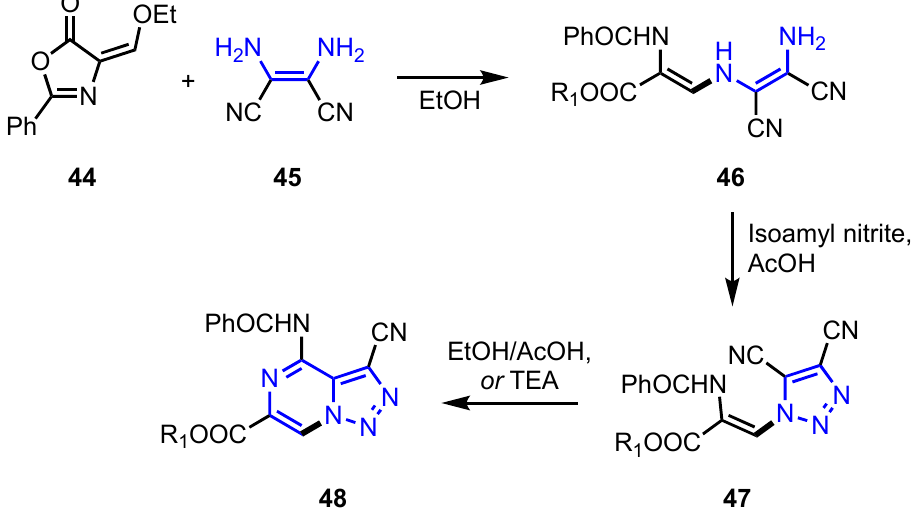
Scheme 10. Reaction of 4-(ethoxymethylene)-2-phenyloxazol-5(4 H )-one 44 and diaminomaleonitrile 45 forming an adduct 46 , which led to triazole 47 and pyrazine 48 . (R 1 = alkyl.) Raghavendra and coworkers [42] reported a triazolopyrazine synthesis employing solid-phase polystyrene p -toluenesulfonyl hydrazide, a common carbonyl scavenging resin. After reaction of the polystyrene p -toluenesulfonyl hydrazide 49 with an acetylpy-